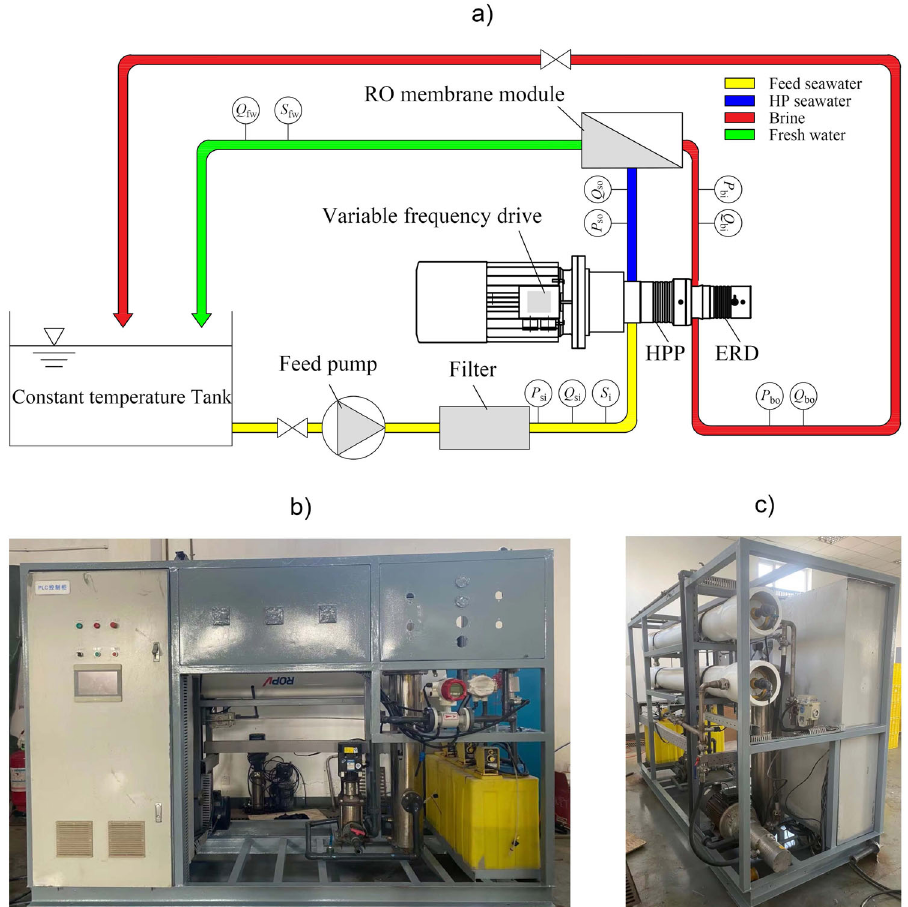
Fig. 5 Portrayal of the experiment platform. a Circulating loops of feed seawater, high pressure seawater, brine and fresh water are illustrated in the fl ow chart. The primary segments of the experiment platform are marked. b Photograph of the experiment platform from the front view. c Photograph of the experiment platform from the oblique view.